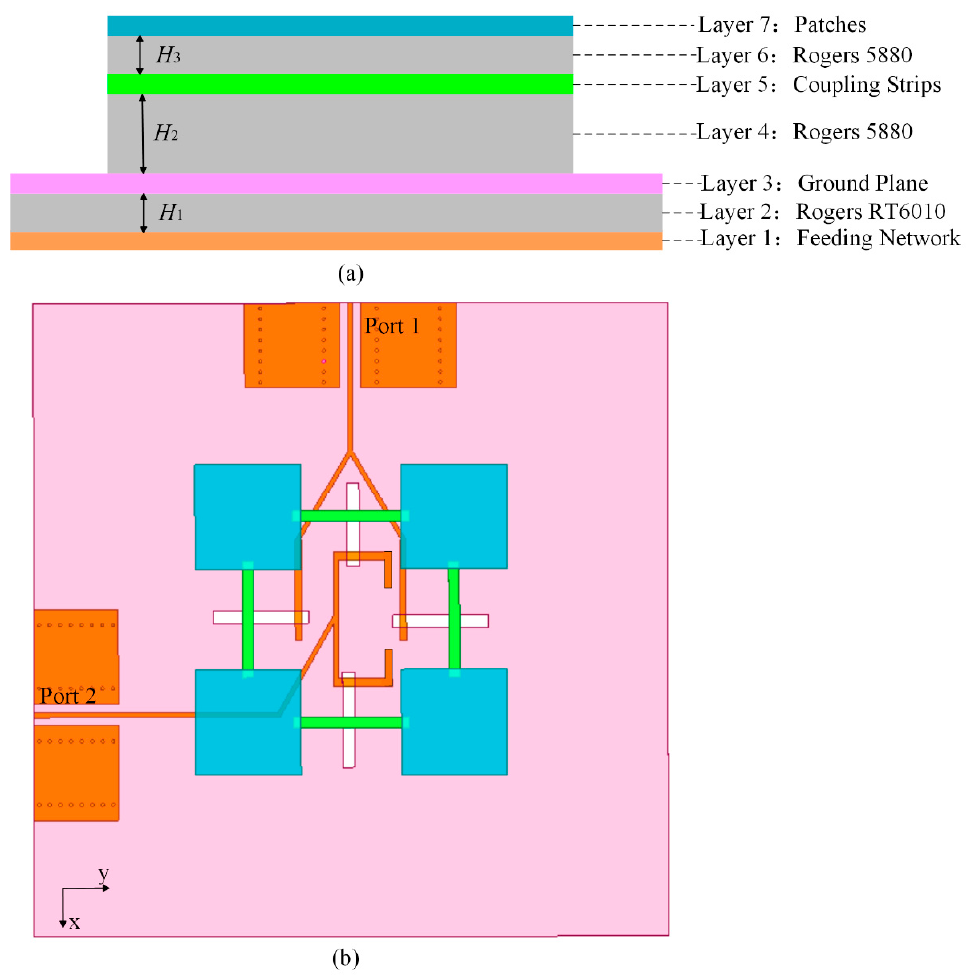
Figure 6. Configuration of the proposed dual-polarized antenna. ( a ) Side view. ( b ) Top view.